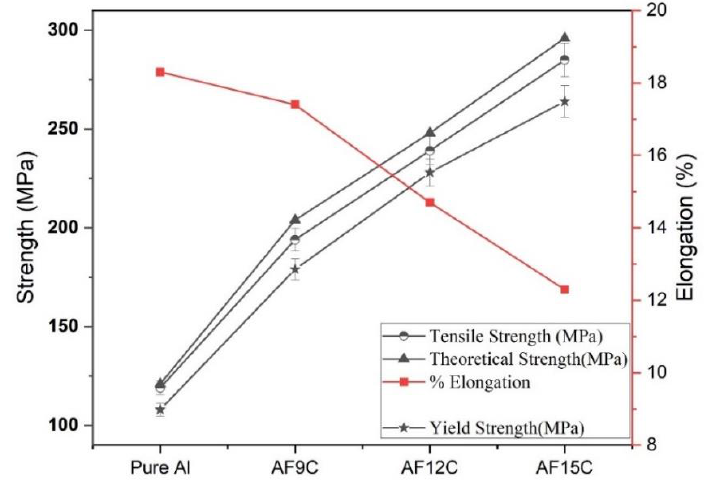
Figure 8. Variation in theoretical strength, tensile strength, yield strength, and strain of the compo- site.